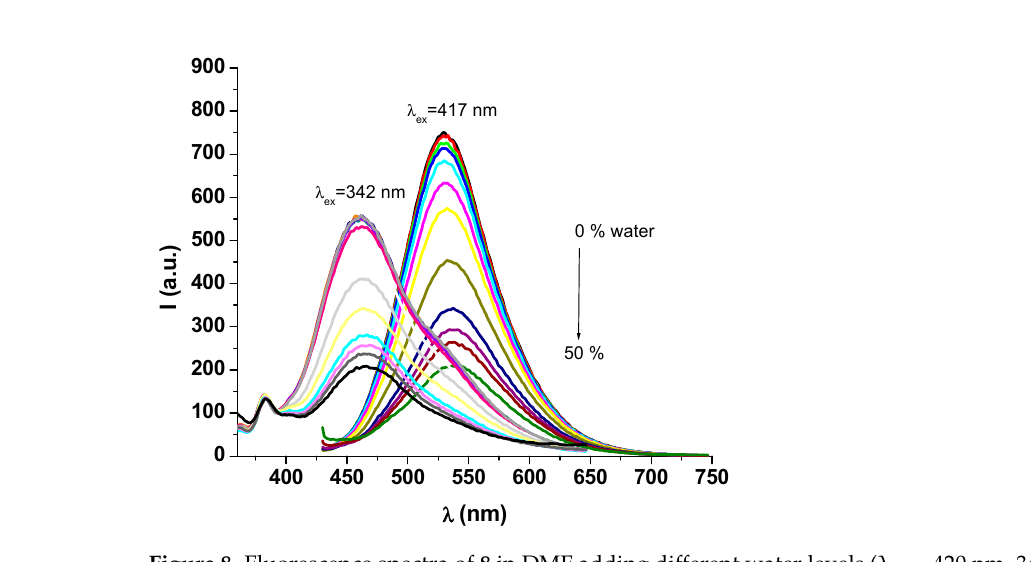
ex = 420 nm, 342 nm).